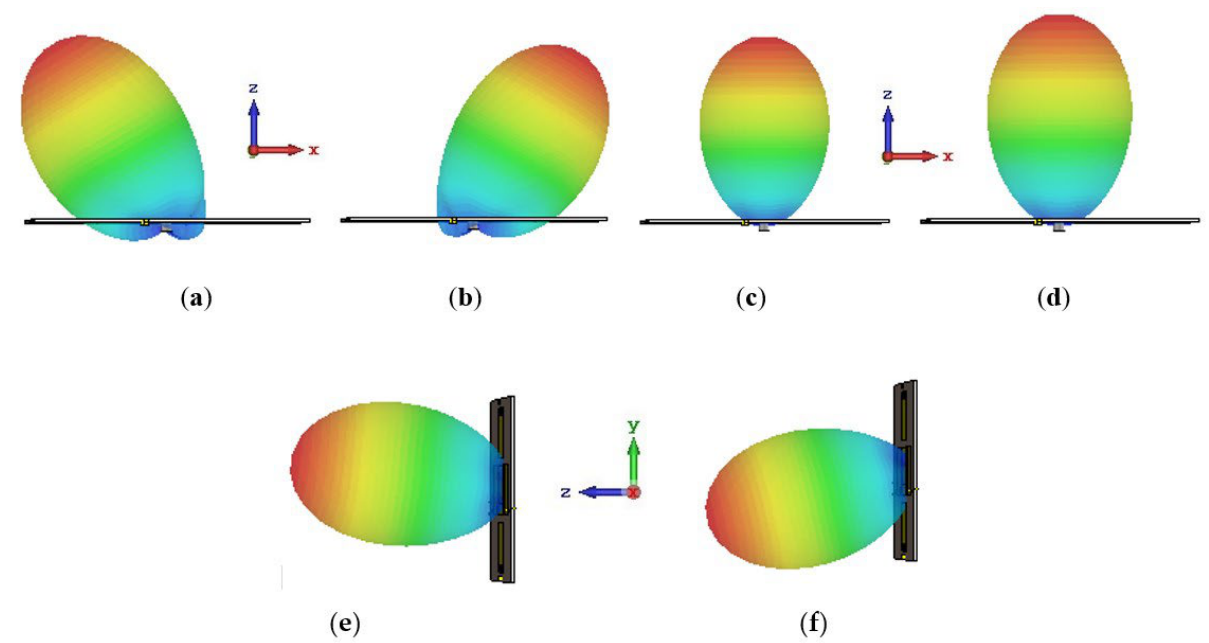
Figure 8. Reflection coefficient: ( a ) simulated ; and ( b ) m easured.